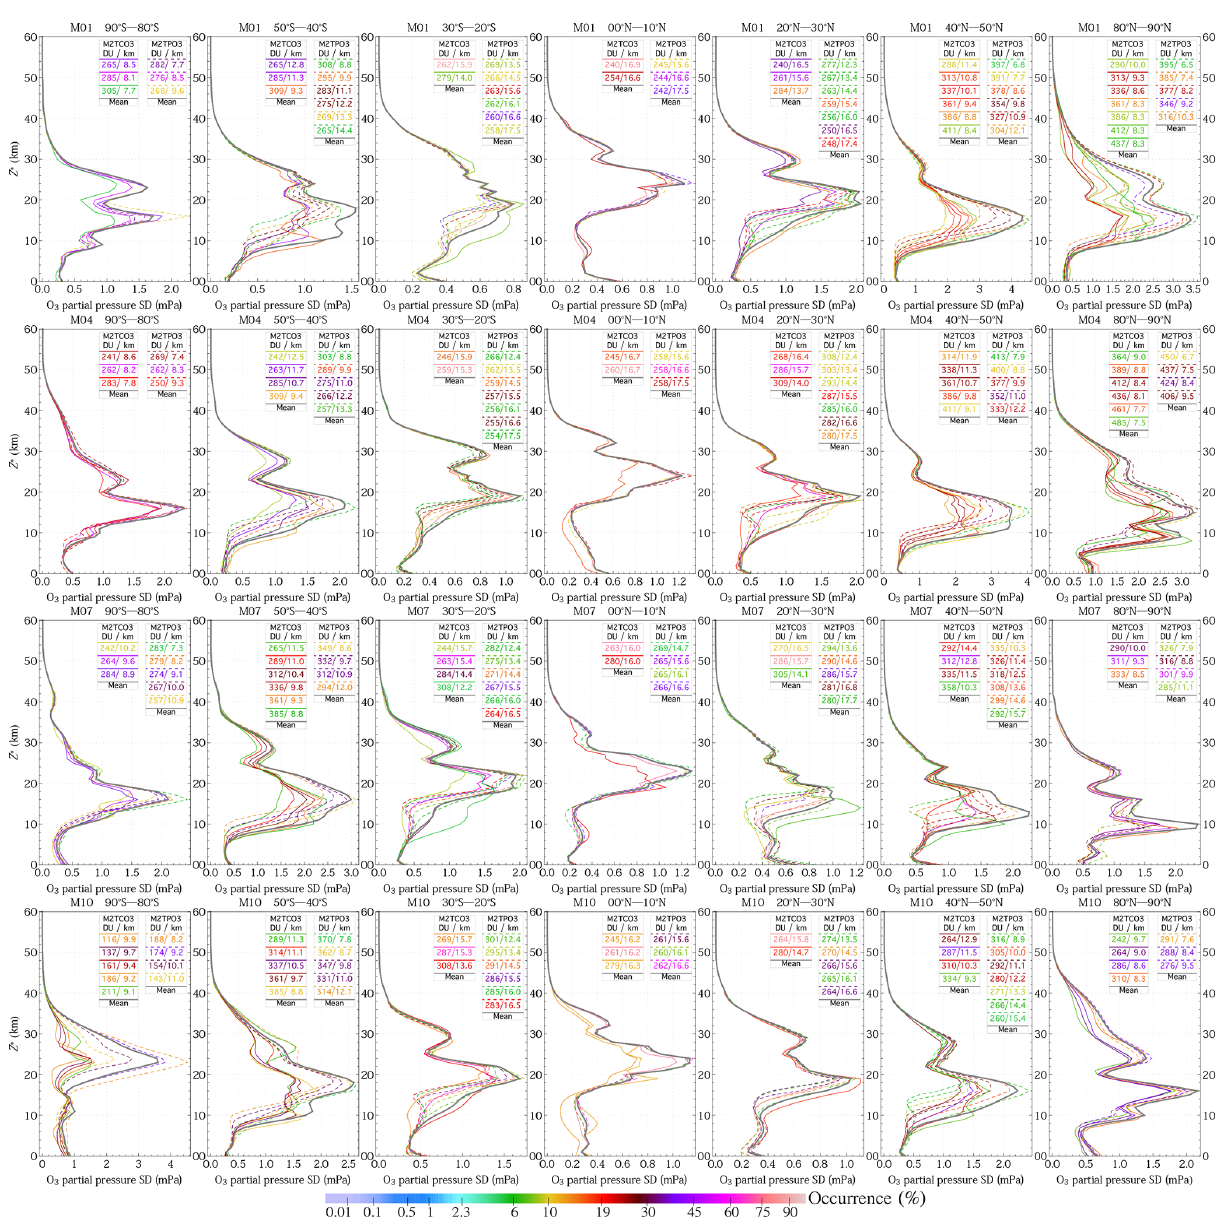
Figure 7. Standard deviation (SD) comparisons between M2TPO3 and M2TCO3 for four months and seven latitude zones (same as those in Fig. 4). Colored solid lines represent M2TCO3 SDs, while colored dotted lines represent M2TPO3 SDs. The color of a solid or dotted line indicates the percentage occurrence of the climatological profile, and its line legend displays the average tropopause altitude and the average total column O 3 . Only SDs for climatological profiles with greater than 5% occurrence are plotted. The solid gray line represents the downgraded M2TCO3 profile SD, i.e., the SD for the monthly zonal mean profile, and it is identical to the SD of the downgraded M2TPO3 profile. The SDs quantify the natural variability of O 3 , and a smaller one signifies that the climatological mean provides a more reliable O 3 profile